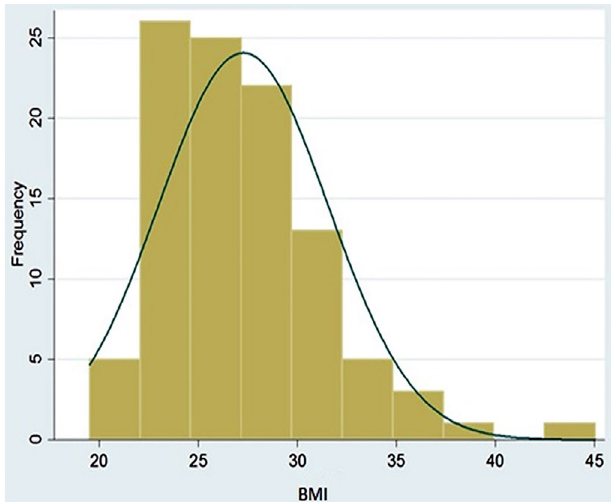
Fig. 1 - Body mass index distribution in pre-operative patients for heart surgery.